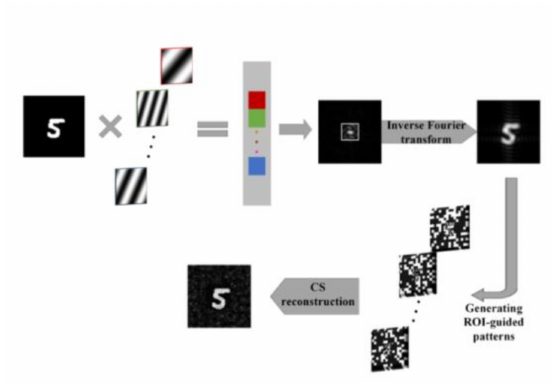
Figure 17. Principle of the R-CSGI.